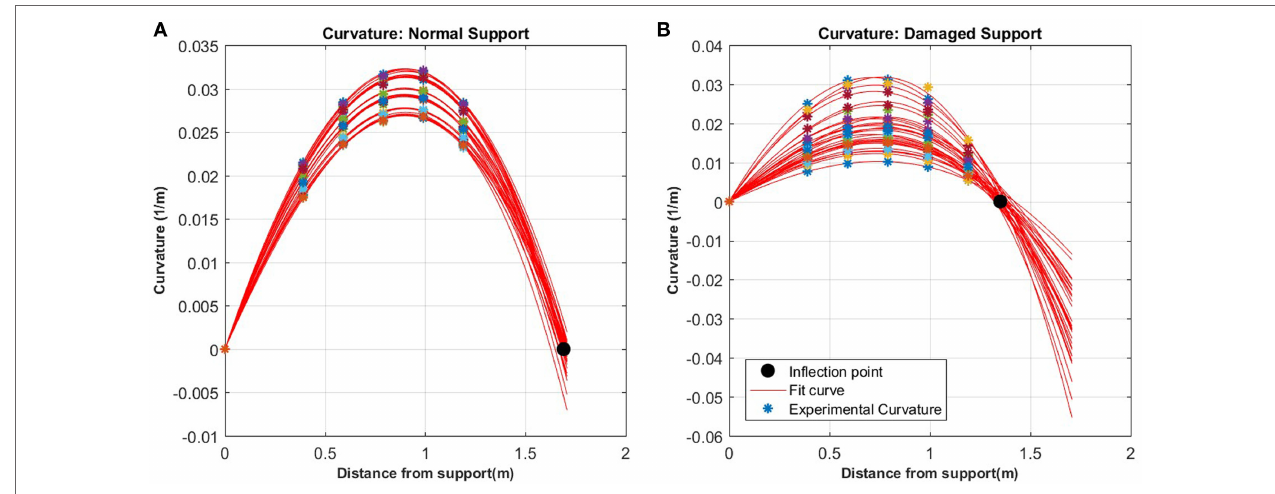
FIGURE 10 | Generic curvature mode shape fit to experimental data for normal support condition (A) versus damaged support condition (B) and the resulting inflection point.